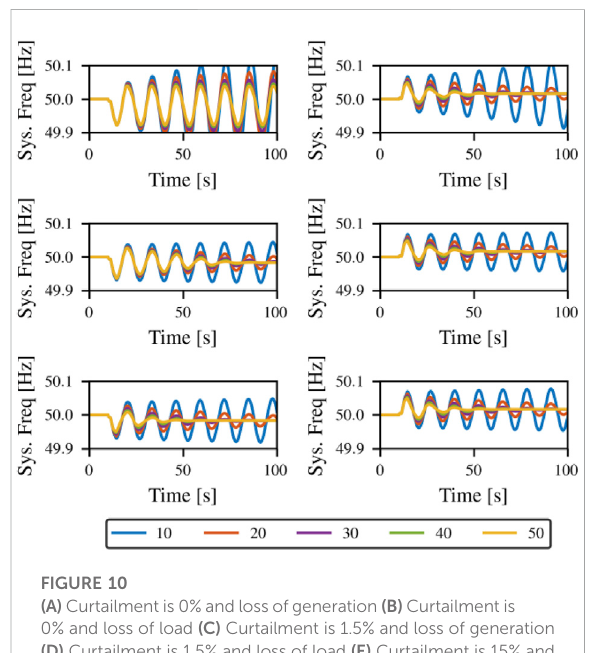
FIGURE 10 (A) Curtailment is0%and loss ofgeneration (B) Curtailment is 0% and loss of load (C) Curtailment is 1.5% and loss of generation (D) Curtailment is 1.5% and loss of load (E) Curtailment is 15% and loss of generation (F) Curtailment is 15% and loss of